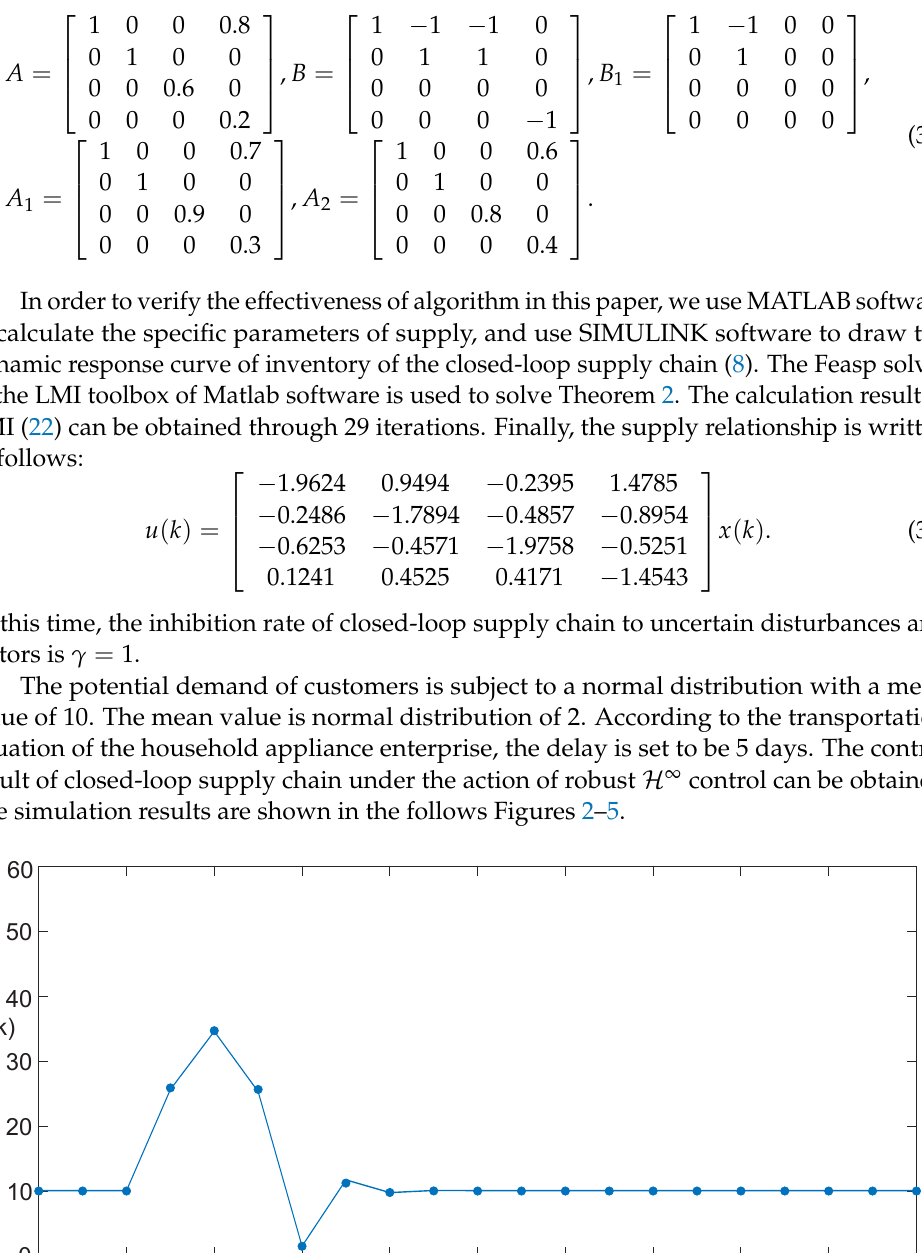
Fig. 8. Response of the designed closed-loop output-feedback control system ( r = 1 and q = 5 ).